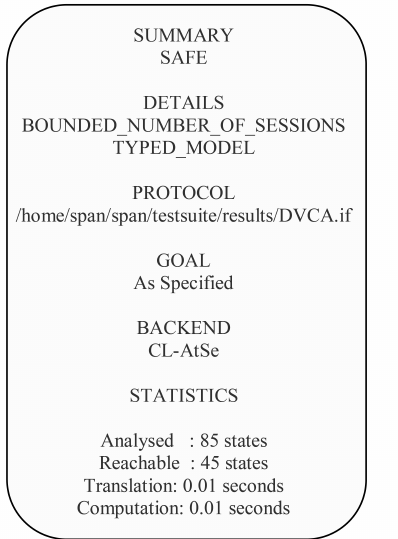
Figure 6. Security validation of DVCA through On-the-Fly-Model-Checker (OFMC) model (AVISPA).